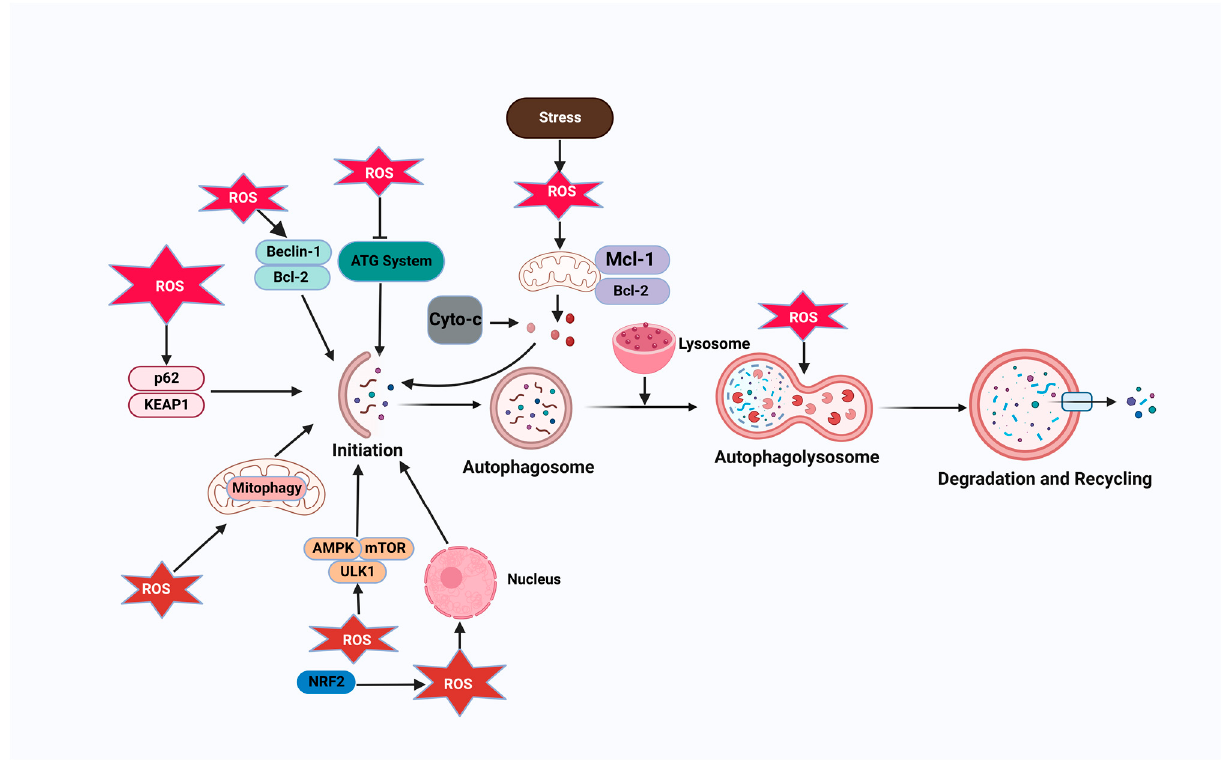
Figure 2. Autophagy–reactive oxygen species (ROS) relationship. ROS levels regulate autophagy through different pathways, including ATG4 oxidation, leading to autophagosome accumulation; the activation of the AMPK signaling cascade to induce autophagy through the ULK1 complex; the disruption of the beclin-1-Bcl2 interaction, leading to autophagy initiation; and the alteration of mitochondrial homeostasis, leading to mitophagy activation. Autophagy limits ROS accumulation by mitophagy or selective autophagy mediated by SQSTM1/p62 and NRF2-regulated antioxidant genes.